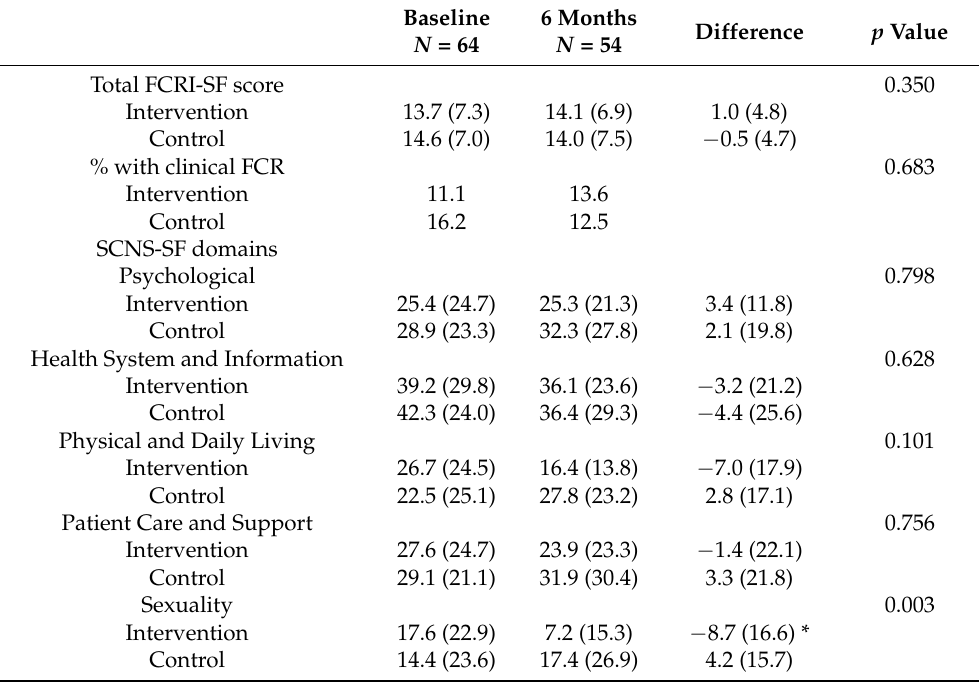
Table 2. Mean summary scores and standard deviation for the fear of cancer recurrence inventory—short form and supportive care needs survey—short form for both groups at baseline and 6-month follow-up, and differences in scores between baseline and 6